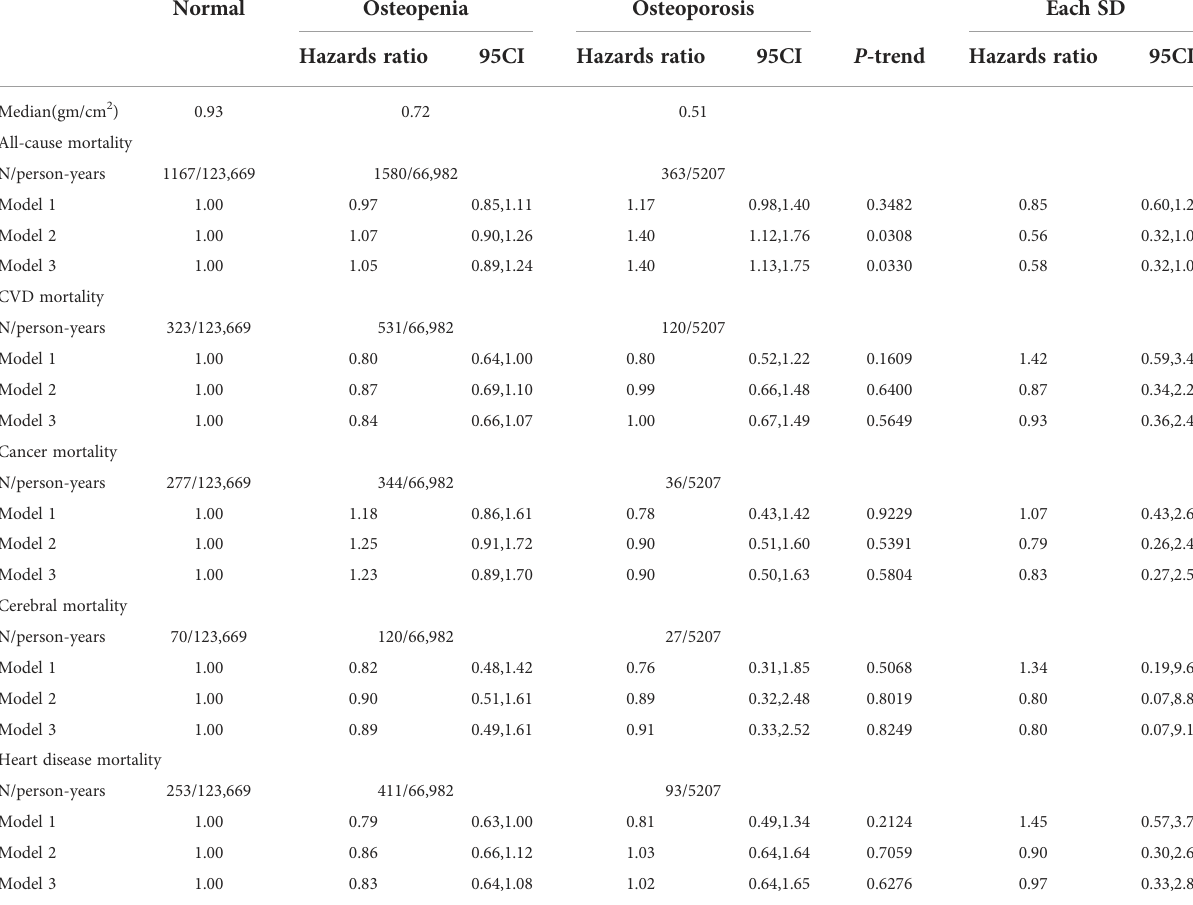
TABLE 2 Hazard Ratios (95% CI) for Risk of CVD, cancer and all-cause mortality according to the groups of bone mineral density.